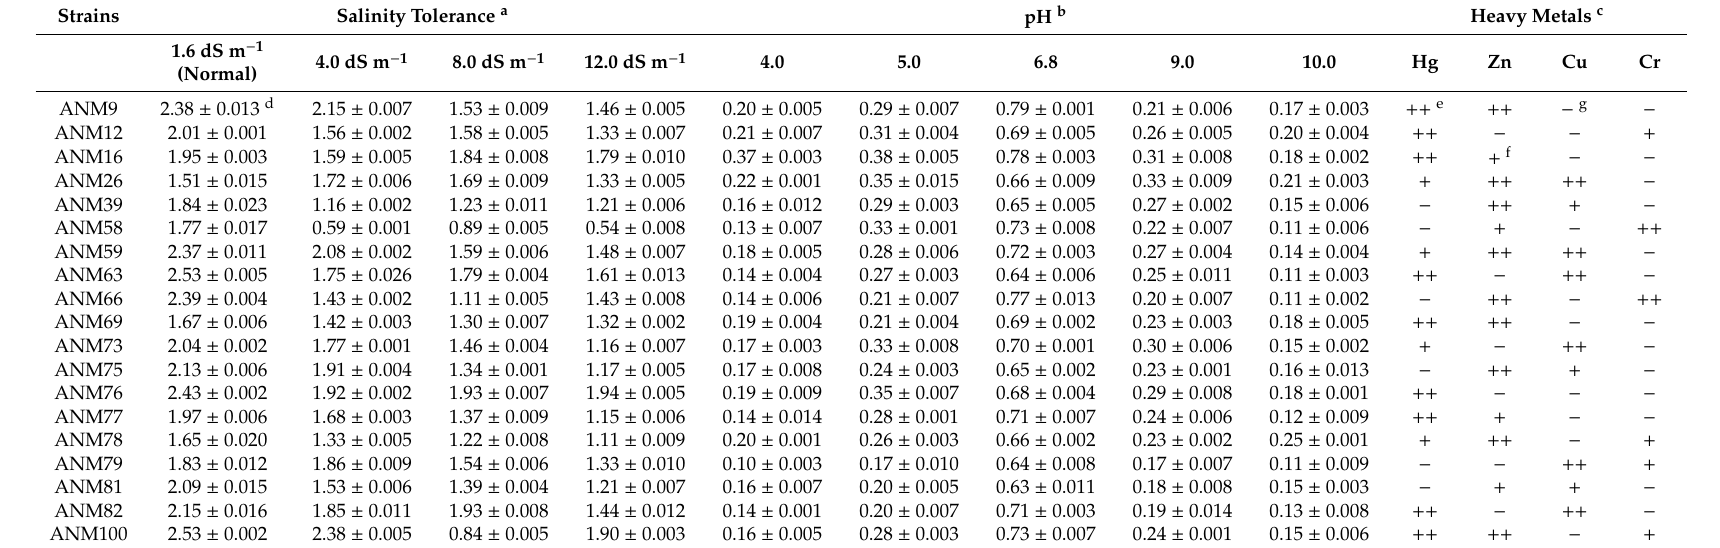
Table 3. Growth of endophytic strains under various salinity and pH levels and heavy metals